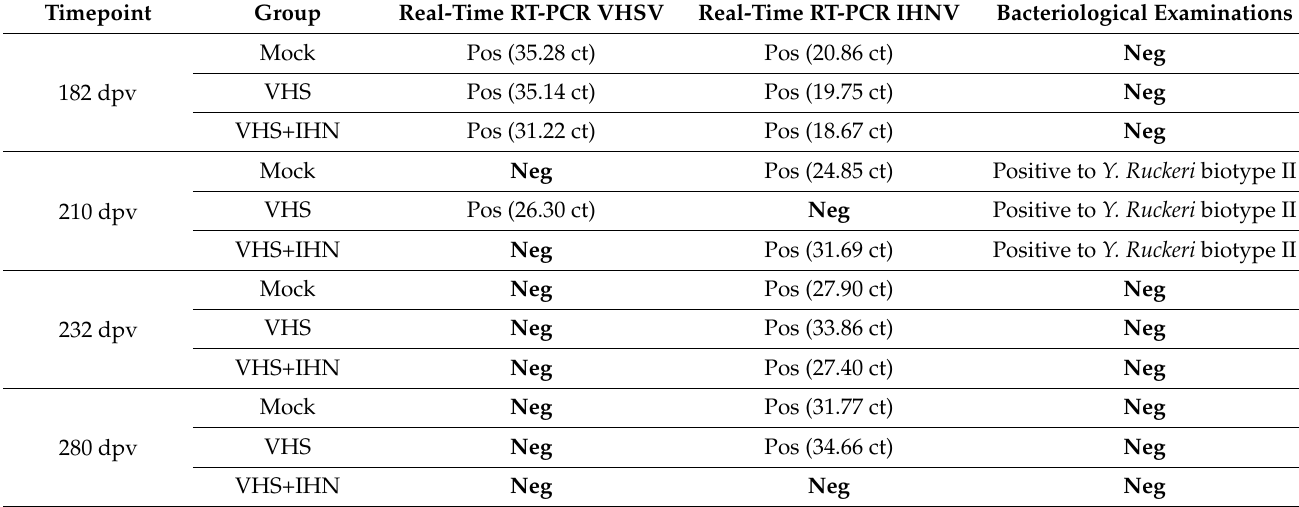
Table 7. Results of the diagnostic examinations performed monthly on pools of moribund/dead fish collected from all experimental groups between 182 and 280 dpv. Numbers in brackets